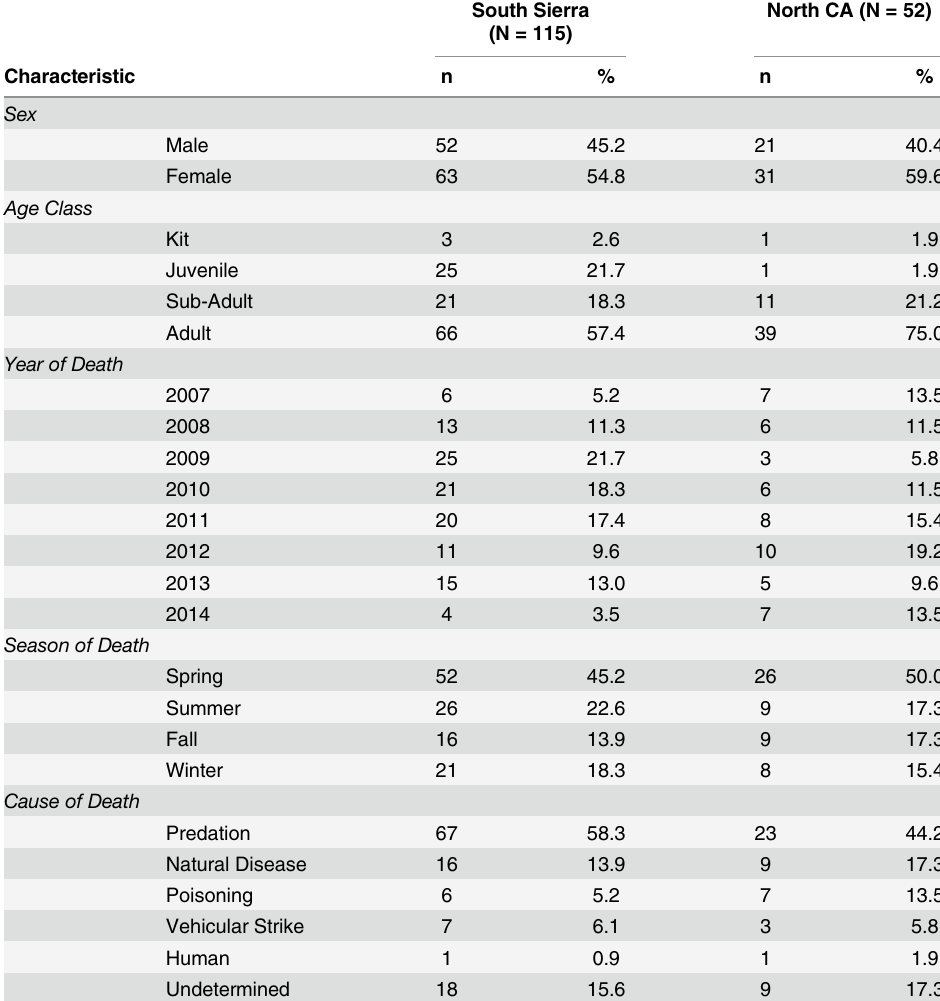
n = 4: 6%), and domestic dogs ( Canis lupus familiaris , n = 2: 3%) were confirmed predators of fishers while a single fisher (1%) was killed by a rattlesnake ( Crotalus oreganus oreganus ).